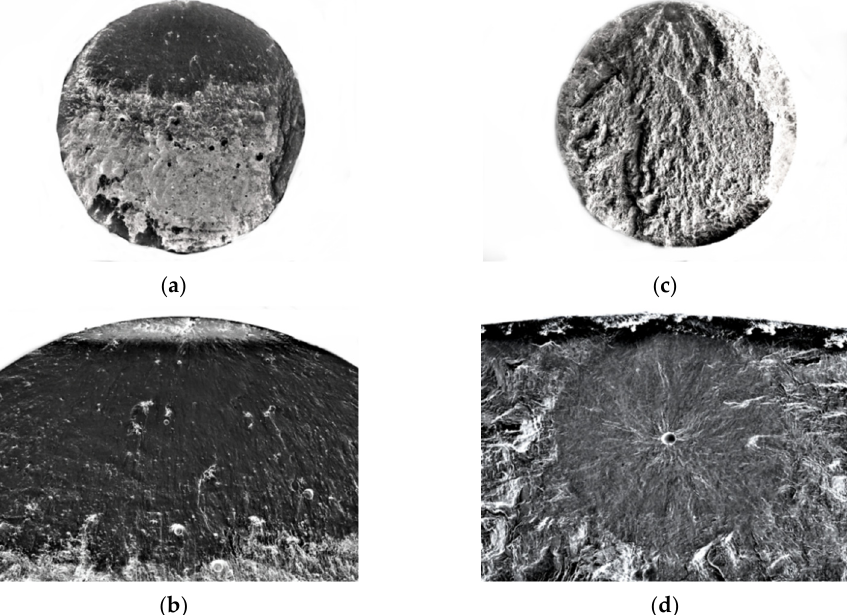
Figure 13. Fractographich morphology of fatigue cracking showing crack geometry: ( a , b ) AlSi10Mg —120 MPa; ( c , d ) Ti-6Al-4V—800 MPa.